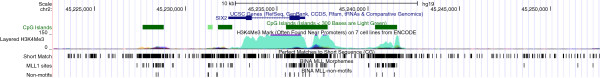
Human genomic DNA with several CGIs and SIX2 gene. Horizontal green bars mark the position of CGIs. Track labeled “Short Match” marks the position of CpGs. Track-labeled “MLL1 sites” marks morpheme positions; “non-motifs” mark the position of sequences not found in results of SELEX assays [24]. Track labeled “Layered H3K4me3” shows the position of H3K4me3 marks [59].